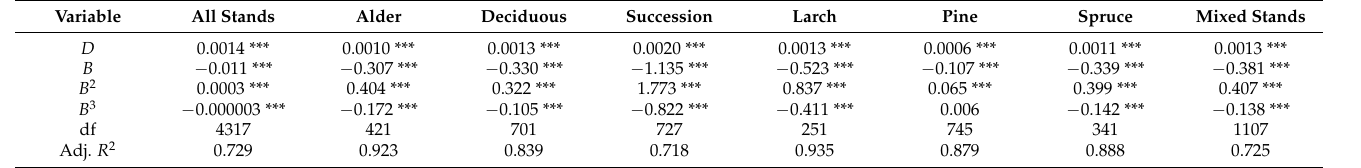
Table 4. Estimated regression parameters of the aboveground tree biomass model (Equation